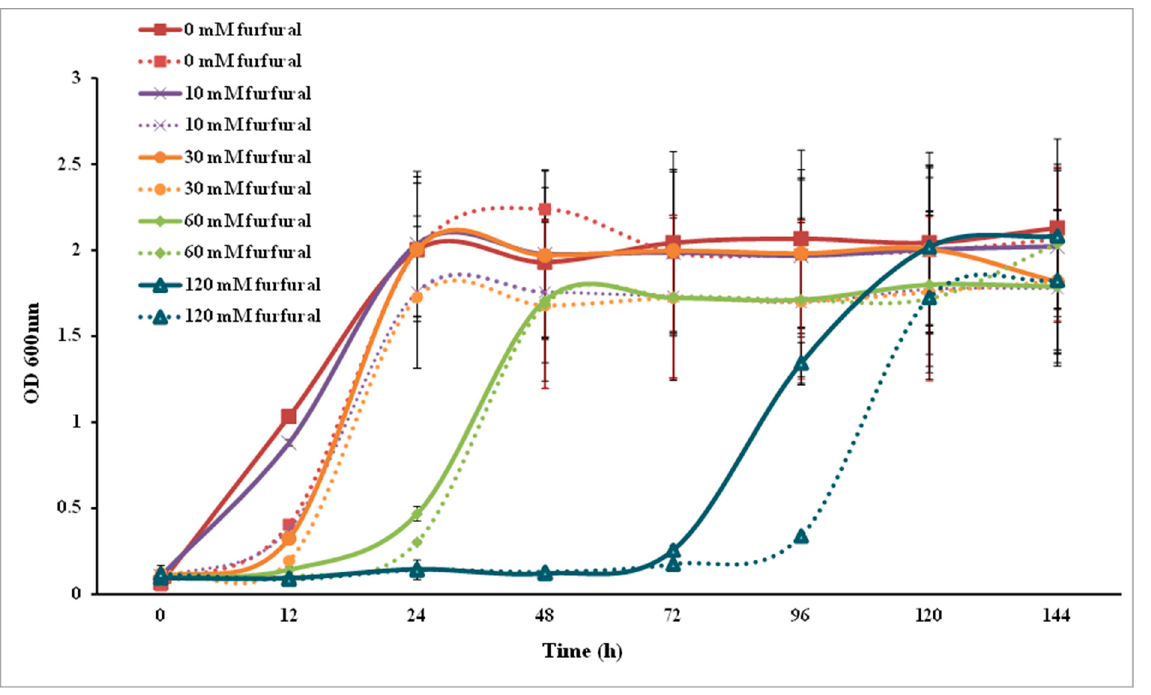
Figure 4. Furfural tolerance analysis of Saccharomyces cerevisiae. Solid lines represent engineered strains; dashed lines represent wild strains.